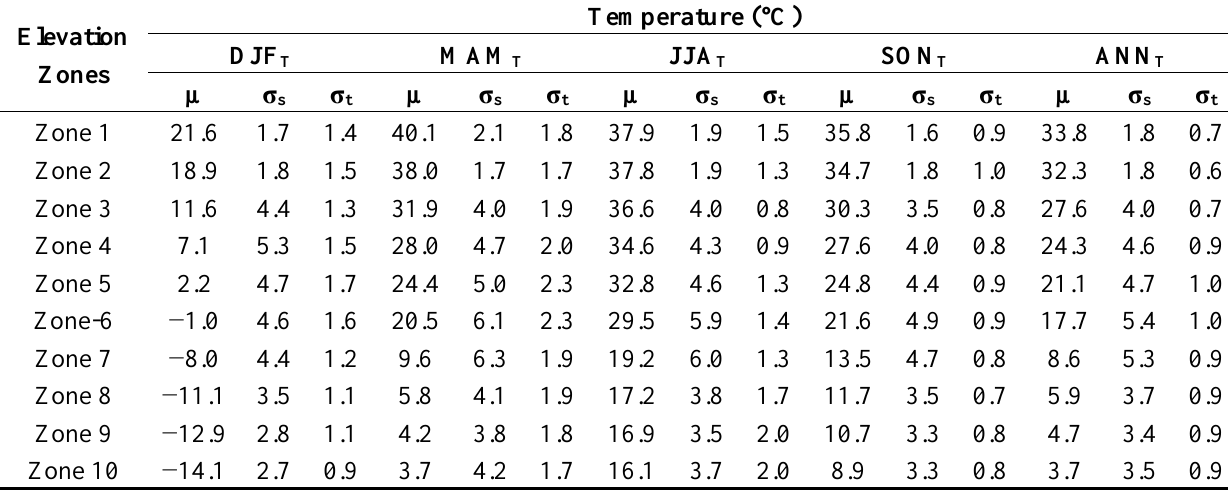
Table 1. Temperature across the elevation zones—average temperature in each zone with the spatial and temporal variability.